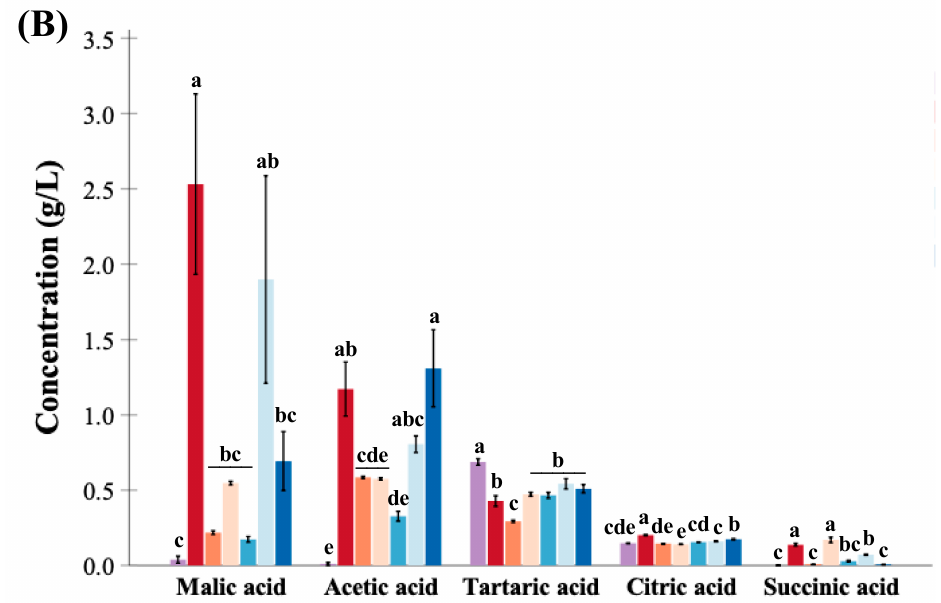
Figure 5. Nonvolatile compounds in sterile juice compared with inoculated fermentations with candidate non- Saccharomyces yeast strains with S. cerevisiae BY4742 as control. UHPLC-RI was used to measure nonvolatile compounds in inoculated fermentation, sugars (glucose and fructose), ethanol, glycerol ( A ), and acids (malic acid, acetic acid, tartaric acid, citric acid, and succinic acid) ( B ). The different types of yeasts used in this study are represented on the x-axis. S. cerevisiae BY4742 was used as a control. Data presented as mean ratio ± SEM with a common superscript indicating significance ( p < 0.05).